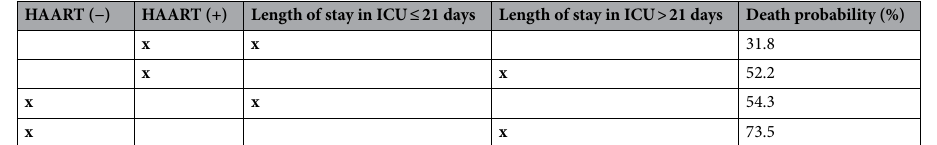
Table 3. Predictive model of mortality in HIV patients upon admission to the ICU. Significant values are in bold.